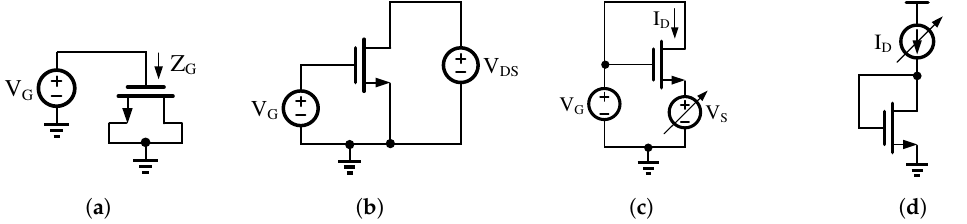
Figure 2. Schematics for device characterization of ( a ) Oxide Capacitance ( C (cid:48) ox ). ( b ) Threshold Voltage ( V TH ). ( c ) Normalization current ( I S ). ( d ) Saturation voltage ( V DSAT ). early voltage ( V A ).